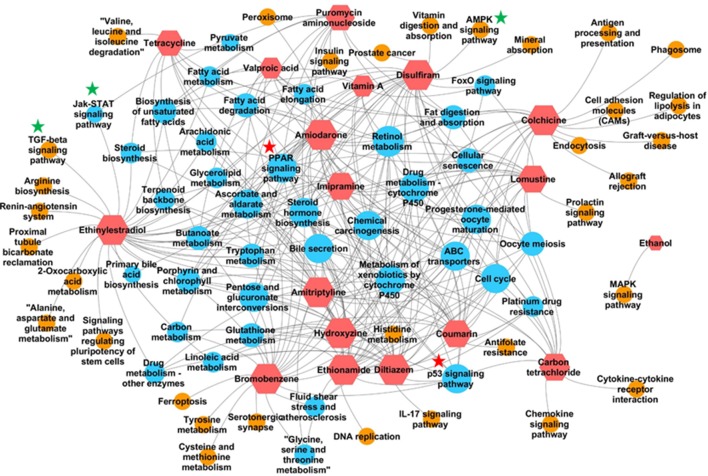
Pathways enriched for each chemical. Red hexagons indicate steatogenic chemicals. Blue circles indicate pathways enriched for two or more chemicals. Orange circles indicate pathways enriched for only one chemical. An edge (shown in grey) was created between the chemical and the pathway if the pathway is enriched in any dose/time exposures for that particular chemical. Signaling pathways enriched for more than two chemicals were marked with red start. Signaling pathways enriched for one or two chemicals were marked with green star.